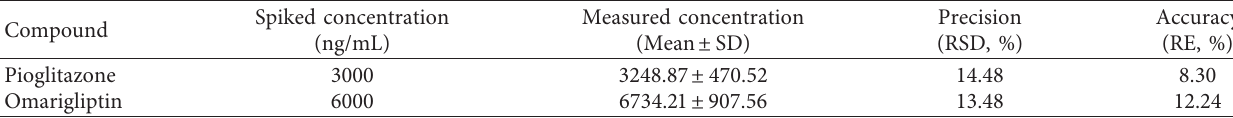
Table 6: Precision and accuracy for the diluted QC samples ( n � 6).